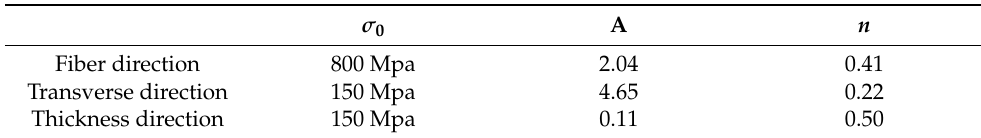
Table 3. The strength of the single-layer plate in different directions and the corresponding material parameters at 0.001/ s reference strain rate.